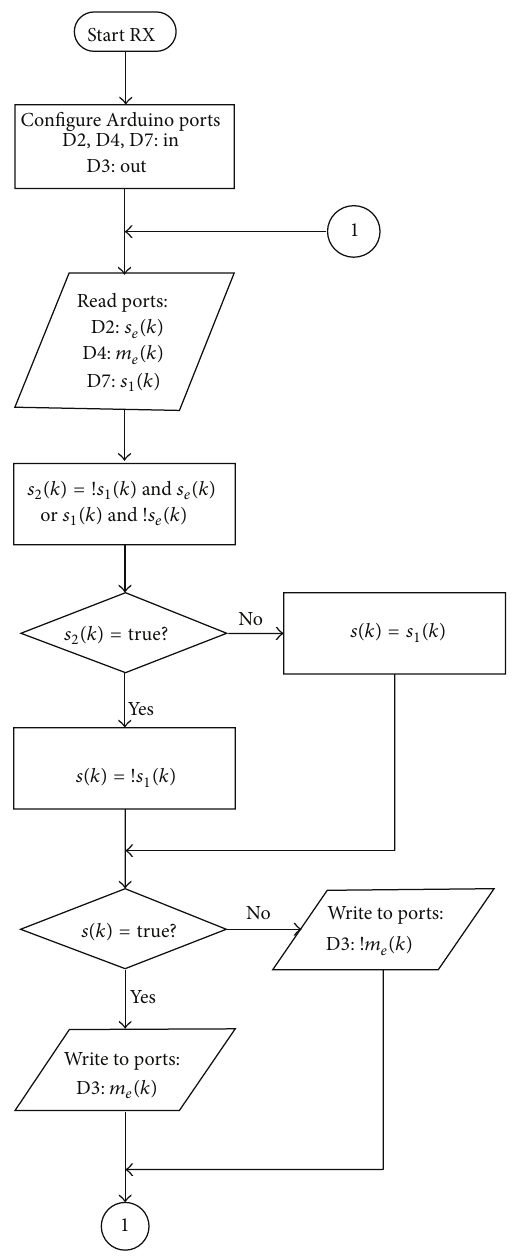
Figure 5: Flow diagram of the receiver Arduino codes.